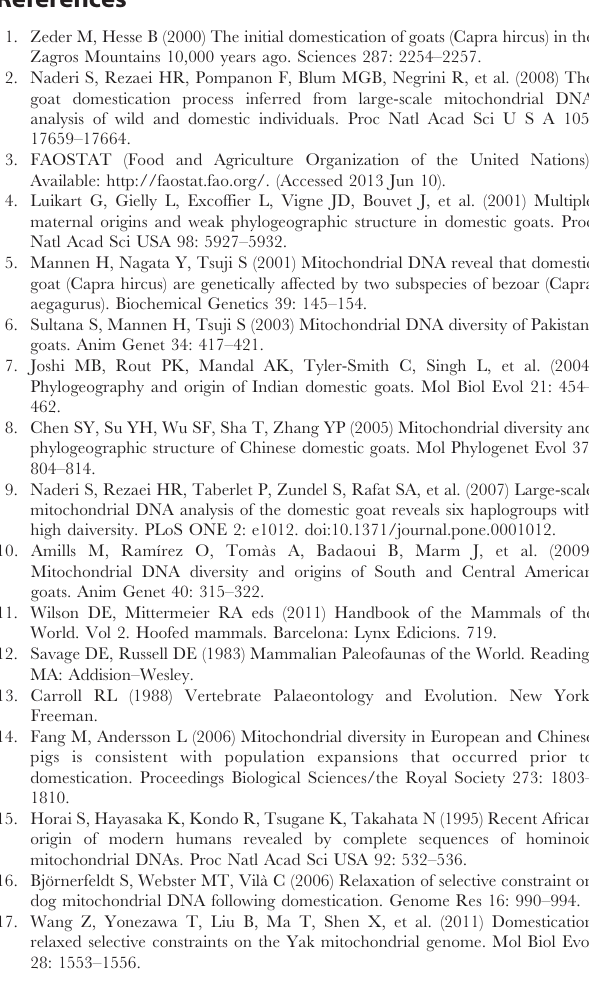
Figure S1 The maximum likelihood tree of domestic goats based on the nearly complete mitochondrial protein-encoding genes of the smaller data set. The GTR + I + G 4 model was used. Taking into account the different tempo and mode of nucleotide substitution, each of the three codon positions was analyzed separately. The branch lengths are proportional to numbers of nucleotide substitutions. The markhor was used as an outgroup. Nodal numbers indicate bootstrap probabilities (rapid bootstrap method: 1,000 replications). Figure S2 Divergence time estimates among Cetartio- dactyla based on the amino acid sequences of the complete mitochondrial protein-encoding genes. The nodal numbers indicate the estimated divergence times 6 standard errors in Ma (mega-annum). Numbers in brackets indicate estimates based on nucleotide sequences. Calibrations are shown in angled brackets. Figure S3 Differences of v ratios among goat lineages based on the larger data set of nearly complete mitochondrial protein-encoding genes. The branch model analysis assuming different v ratios in the shallow branches (a); and the branch model analysis assuming different v ratios in the